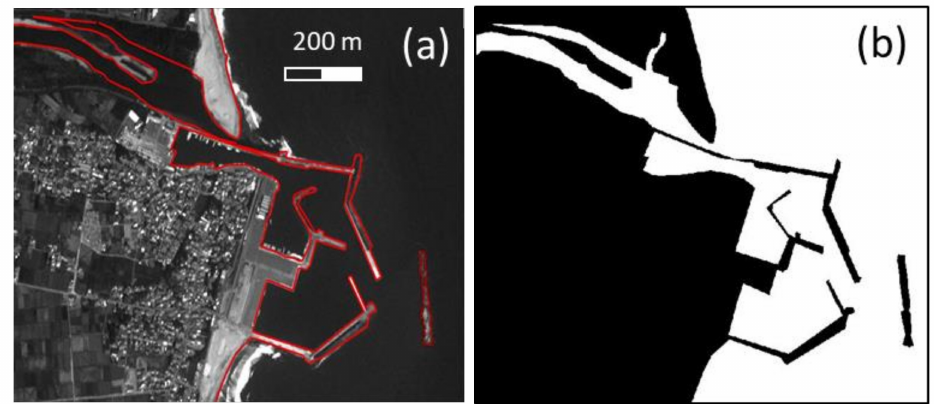
Figure 5. ( a )ReferenceshorelineontheUkedoharborand( b )referenceland / oceanmapon8November2010. Two types of comparisons are carried out to evaluate the performances of the classification